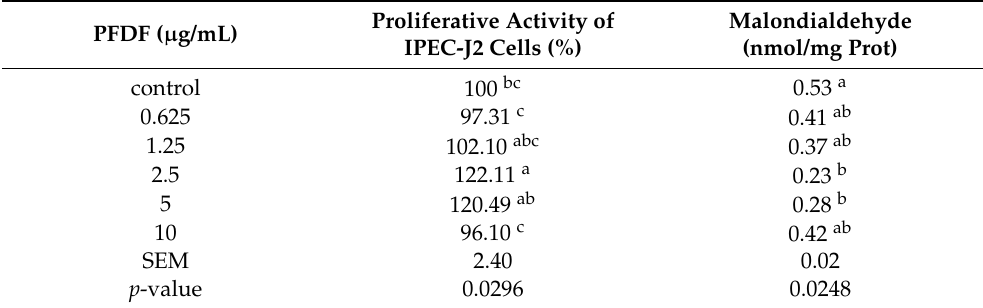
Table 3. Effect of PFDF on the proliferative activity and MDA content of IPEC-J2 cells.